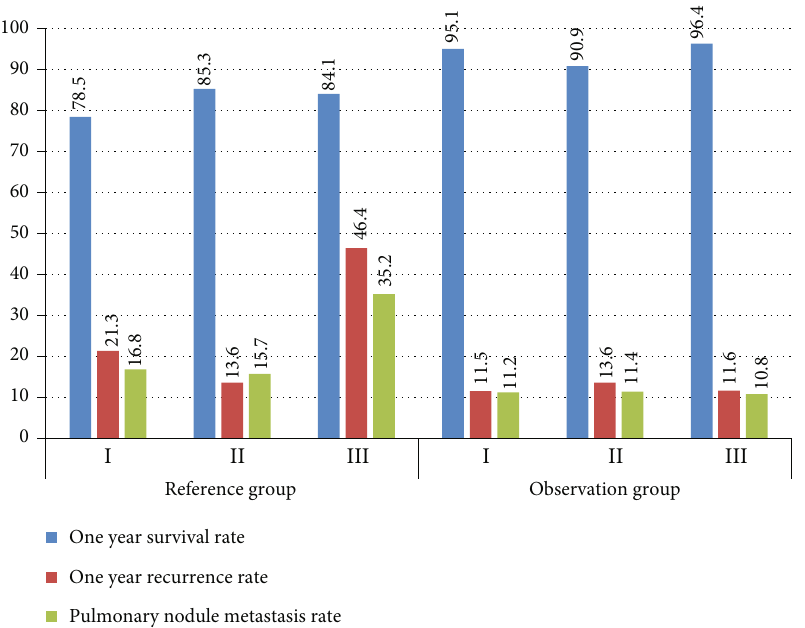
Figure 3: Comparison of the observation results of prognosis and quality of life of di ff erent examination